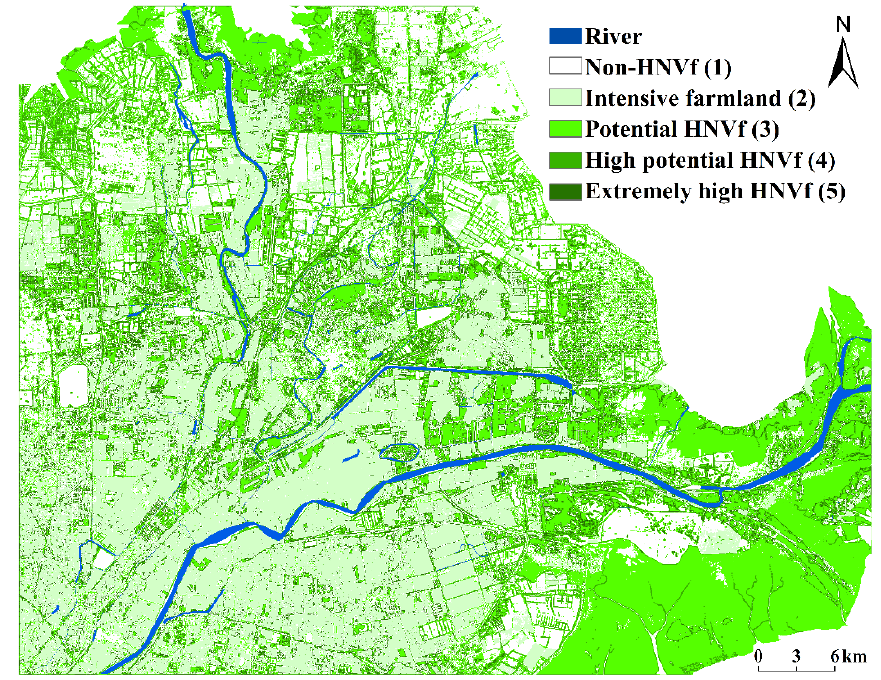
Figure 8. The spatial distribution of HNVf type 2 in the study area.